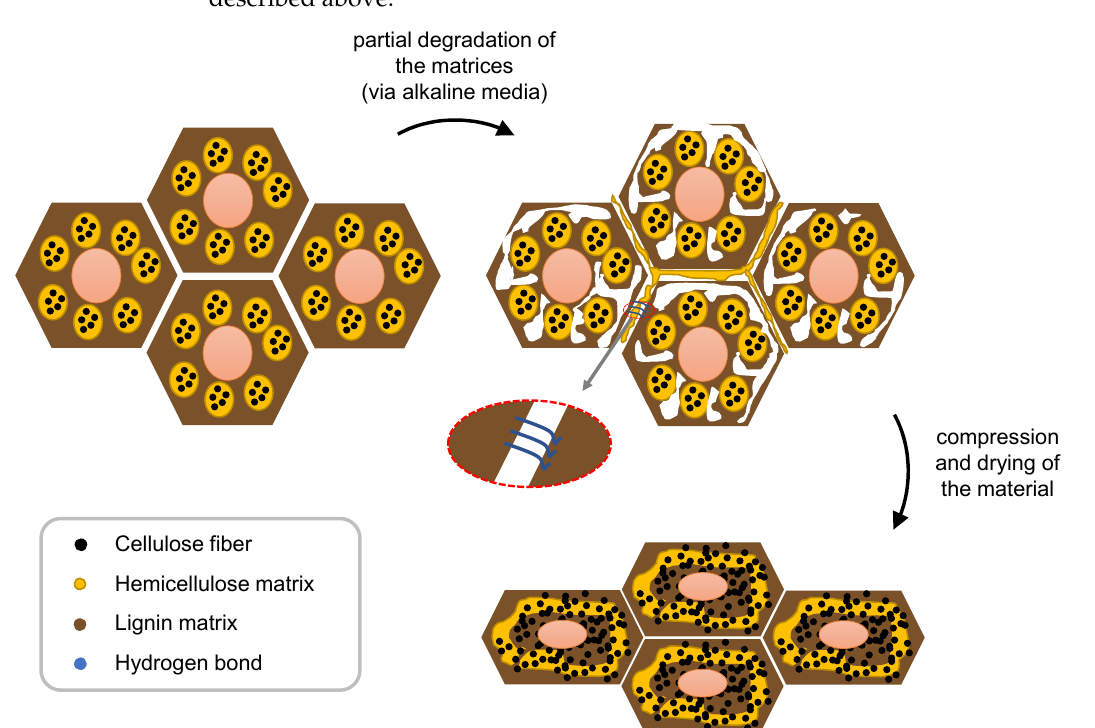
Figure 5. A scheme of the wood delignification and densification processes.